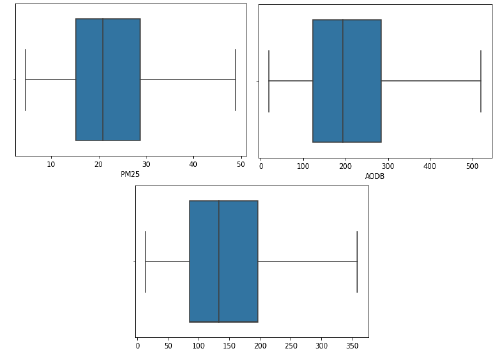
Figure 5. Box plots of the input parameters for PM 2.5 models.